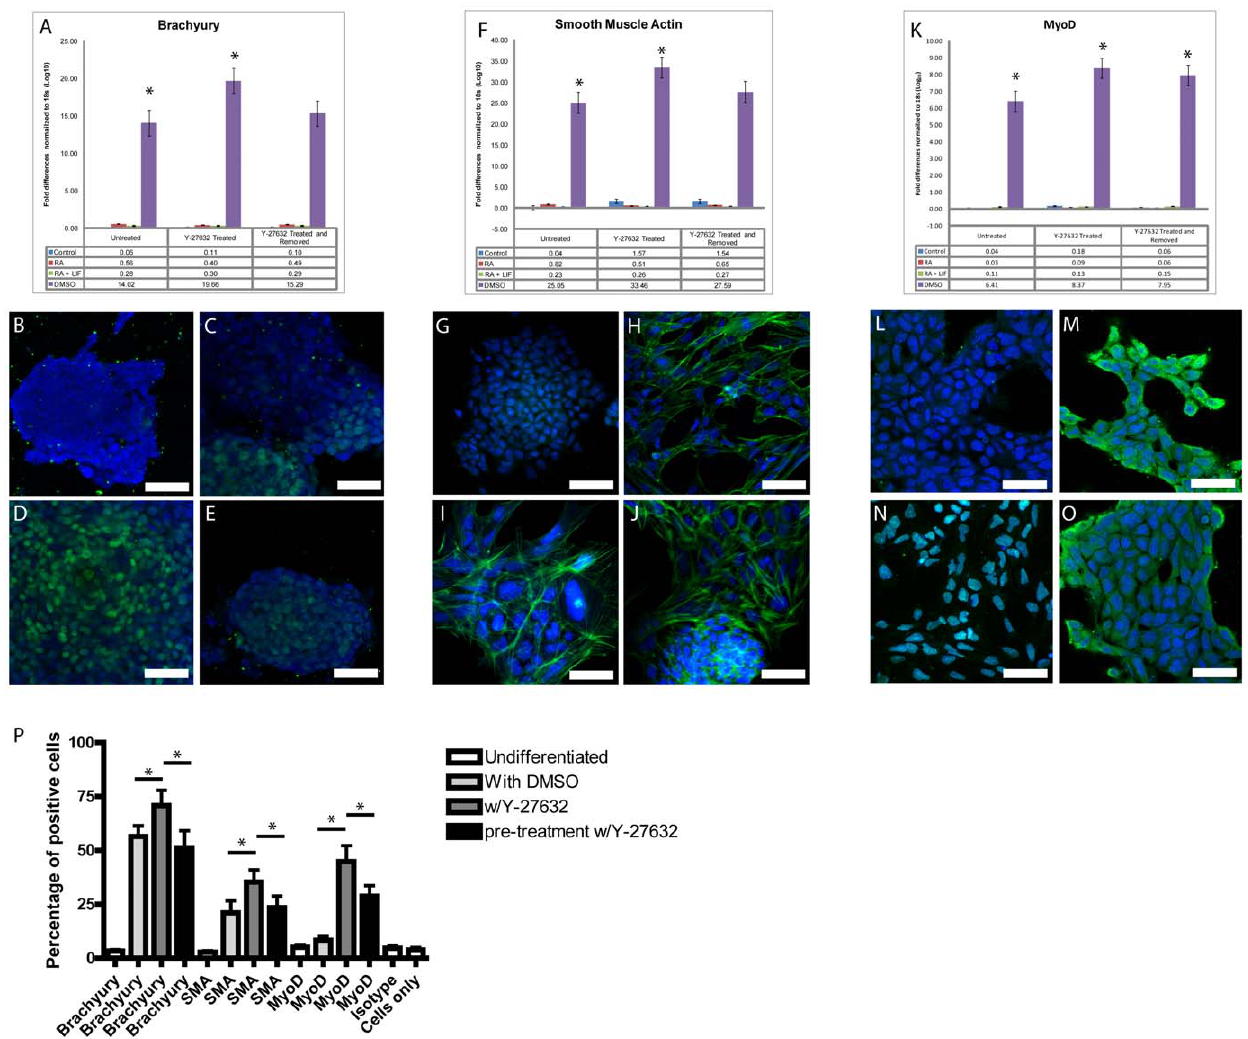
Figure 2. Differentiation of P19 cells into mesoderm is enhanced by Y-27632 treatment. P19 aggregates were treated with 1% DMSO to induce differentiation into mesoderm. Total mRNA was collected and probed with Brachyury, an early mesodermal marker. P19 cells treated with DMSO displayed an increase in Brachyury expression compared to cells treated with Y-27632 (A). Immunofluorescence analysis of cells either undifferentiated (B) or treated with DMSO treated (C) DMSO + Y-27632 treated (D) or DMSO treatment with Y-27632 pre-treatment (E) showing Brachyury localized to the nucleus. qPCR results for SMA show expression levels had increased following DMSO + Y-27632 treatment (F). Immunofluorescence of SMA in undifferentiated (G) DMSO treated (H) DMSO + Y-27632 treated (I) or DMSO treatment with Y-27632 pre-treatment (J). MyoD mRNA expression also increased with Y-27632 treatment in the presence of DMSO (K). Immunofluorescence of MyoD in undifferentiated cells (L) and in those treated with DMSO (M) DMSO + Y-27632 treated (N) or DMSO with Y-27632 pre-treatment (O). FACS analysis demonstrates a significant increase in Brachyury, SMA and MyoD positive cells with Y-27632 treatment (P). Scale bar equals 50 m m, green staining represents the primary antibody, and blue staining is the nuclear dye TOTO-3. * Significance accepted at p , 0.05.